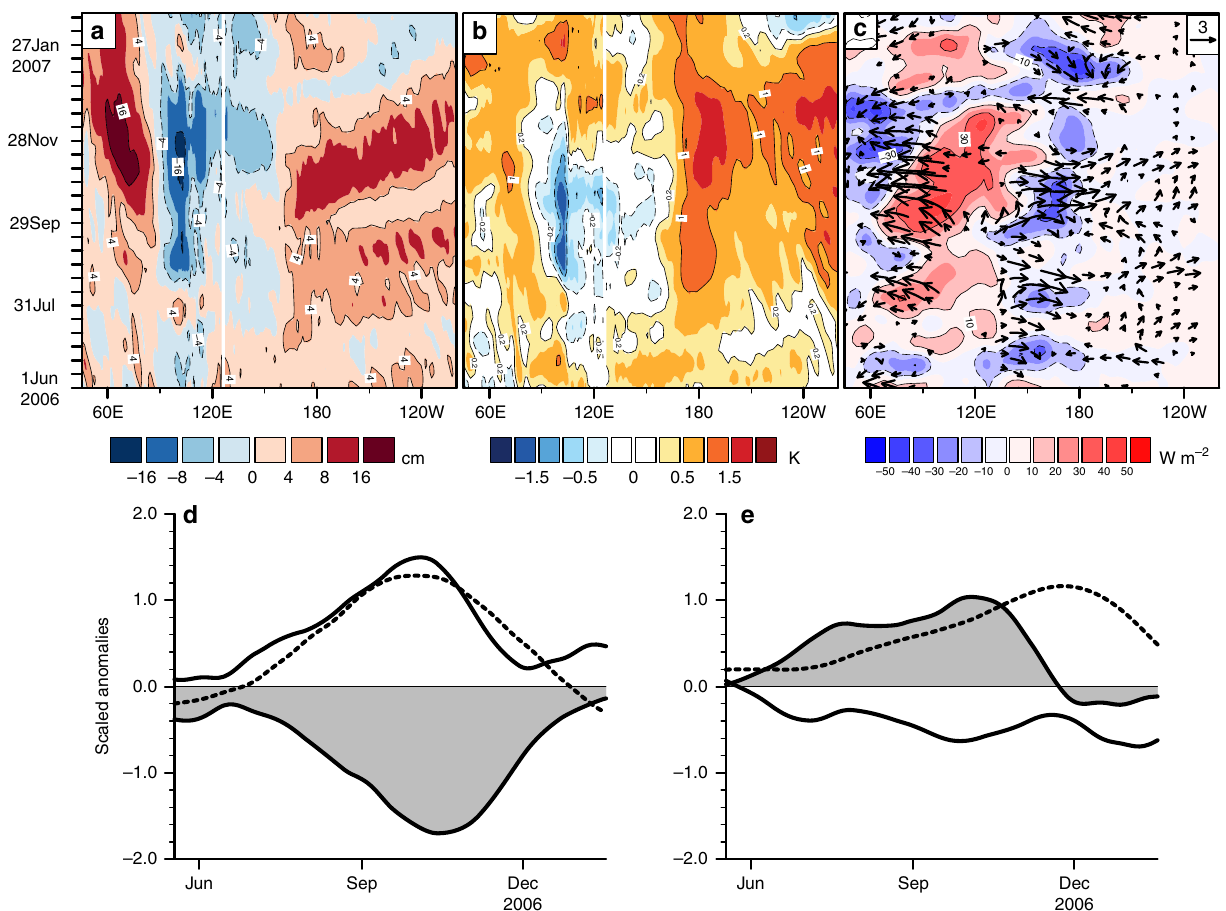
Fig. 6 Evolution of Indo-Paci fi c climate anomalies during 2006. Time-longitude evolution of a sea surface height (SSH), b SST, and c outgoing longwave radiation (OLR) and surface zonal wind anomalies (vector, units: m s − 1 ). All variables were averaged between 5°S and 5°N, except over the Indian Ocean — here, SST, SSH, and OLR anomalies were averaged from 10°S to the Equator, considering their strong equatorial asymmetry during IOD. We used daily resolution data that were low-pass Lanczos fi ltered to remove (weather) variations shorter than 30 days. IOD strong and robust positive OLR anomalies over the eastern equatorial Indian Ocean drive easterly anomalies over the Indian Ocean, as the Rossby wave response, and westerly anomalies over the Paci fi c, as the Kelvin wave response. Area-averaged anomalies over selected regions contrast the nature of ocean – atmosphere coupling in the Indian ( d ) and Paci fi c ( e ) oceans — the time series were further smoothed with a 31-day running mean. In d , DMI (dashed line) evolves tightly in step with equatorial Indian Ocean zonal wind (shaded curves, 80°E – 100°E) and OLR anomalies (solid line, 80°E – 110°E). In sharp contrast, over the equatorial Paci fi c ( e ), Nino3.4 SST (dashed line) anomalies signi fi cantly lag both equatorial zonal wind (shaded curve, 150°E – 180) and OLR (solid line,150°E – 180°E) anomalies. In d and e , zonal wind was divided by a factor of 2 and OLR by IOD event in the tropical Indian Ocean. This forcing (shaded contours in Fig. 5d – f) consisted of two elliptical patches: the Indian Ocean, and the positive patch represents anomalously